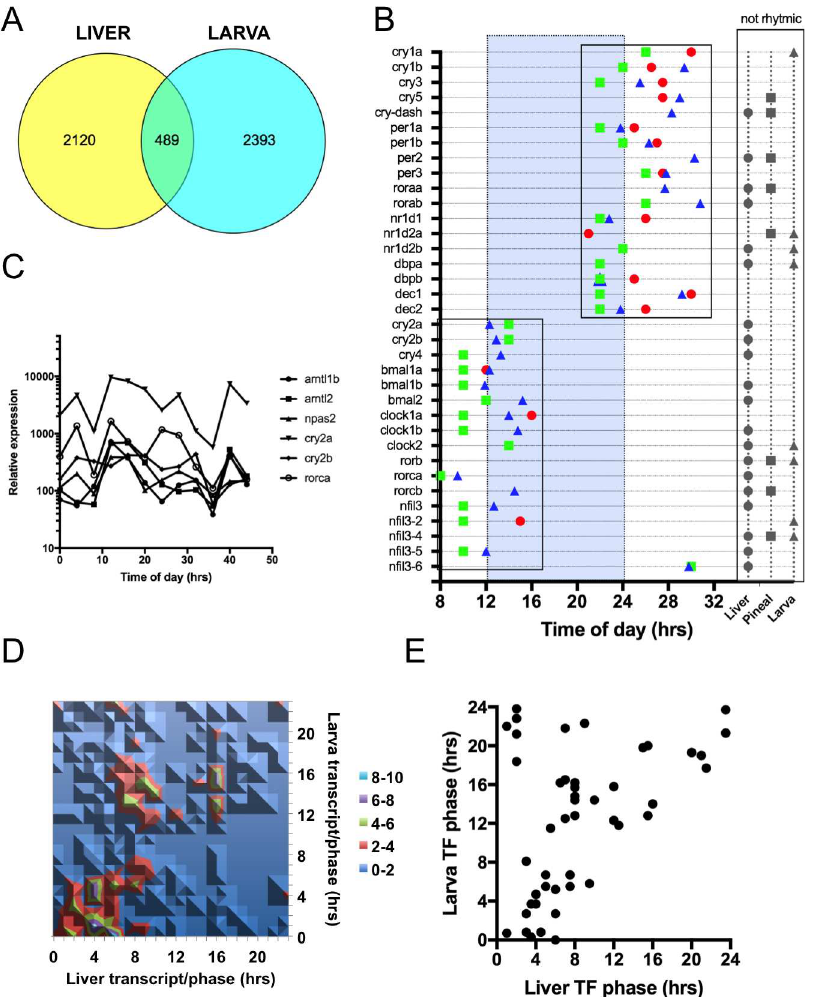
Fig 2. Comparison between Zebrafish larval and liver time courses. (A) Venn diagramof the rhythmic transcripts identified in Zebrafish larva and liver. The larval genesare the common rhythmic genesfrom 5d old larva collectedevery 4hrs under LD (14:10) and DD (2882 ENSEMBL genes)[43].(B) Expression phases of clock genesin zebrafish pinealgland, larva and liver. Red circle: liver; Green square: pinealgland (from [44]; Blue triangle: larva. Grey symbols correspond to arrhythmic genes. (C) Diurnalprofiles of selectedarrhythmic liver clock genesfrom panel B. (D) Contour plot of the 489 common cycling genesbetweenthe liver and larval time courses. Color code in legendrepresentsthe number of genesat each phaseintersection. (E) Scatter plot of the phases of all cycling TF genesbetweenthe liver and larval time courses.